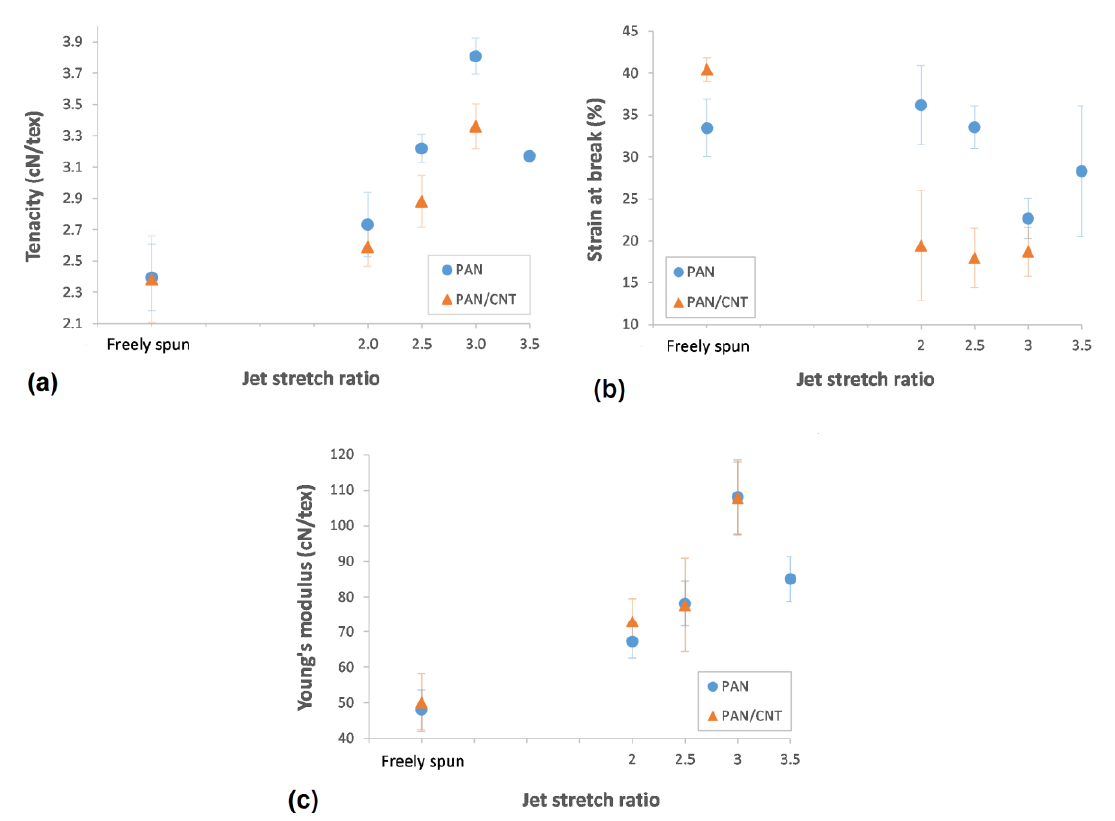
Figure 11. ( a ) Tenacity, ( b ) strain at break and ( c ) Young’s modulus of PAN and PAN / CNT fibers as a function of jet stretch ratio.